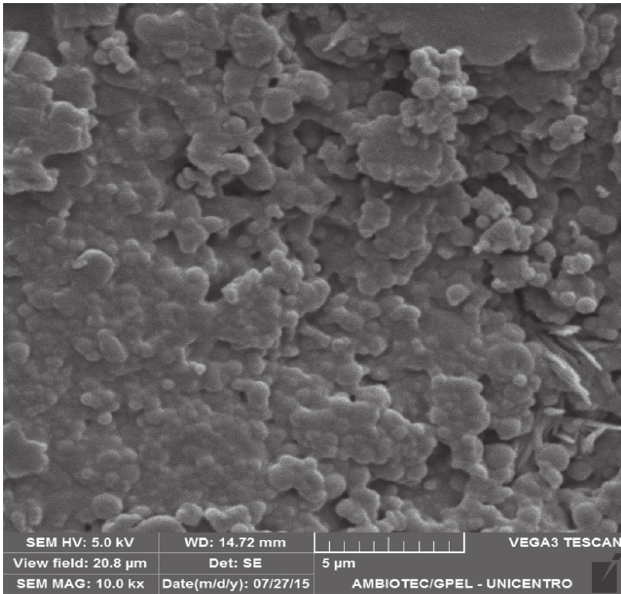
FIGURE 2 - SEM image of BSA nanoparticles containing rutin with increase of 10